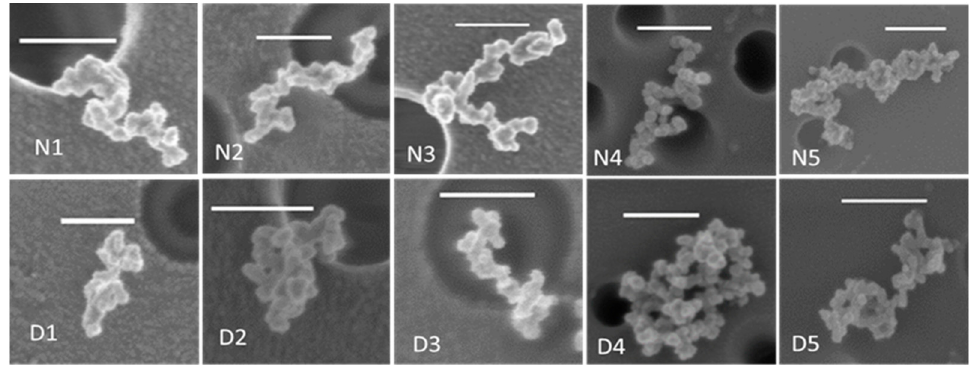
Figure 3. SEM micrographs of nascent ( N ) and thermodenuded ( D ) soot particles. The white horizontal bar in each micrograph represents a length scale of 200 nm. Dark circles are the holes in the filter.